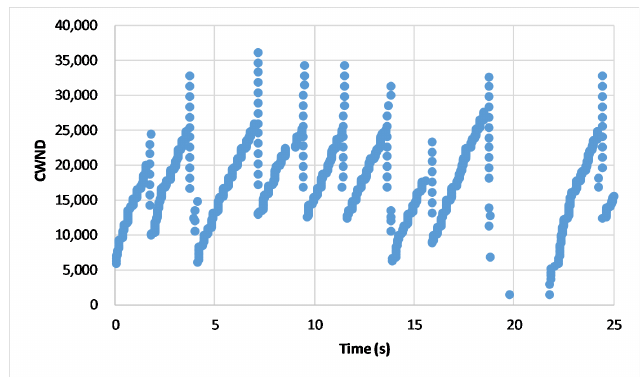
Figure 7. Real-time CWND in the proposed scheme.